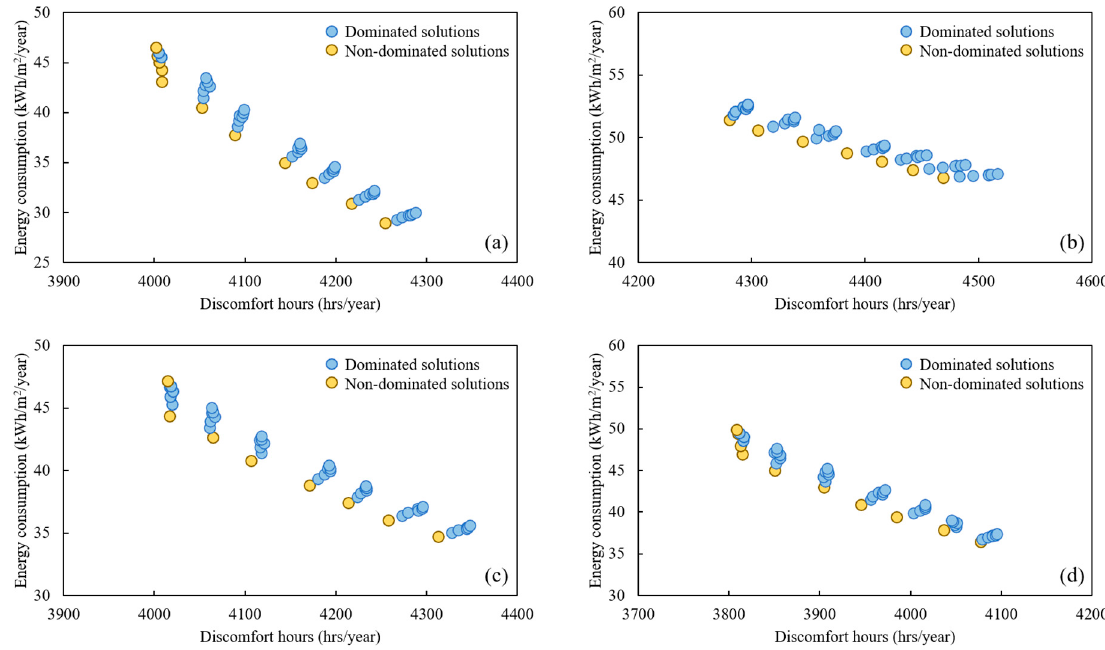
Figure 5. Trade-off between annual discomfort hours and net thermal energy consumption with the variations of U in and SHGC out for NoVent-DSF (cold months, Sydney) and NatVent-DSF (hot months, Sydney) for di ff erent orientations: ( a ) North, ( b ) South, ( c ) East, and ( d ) West.